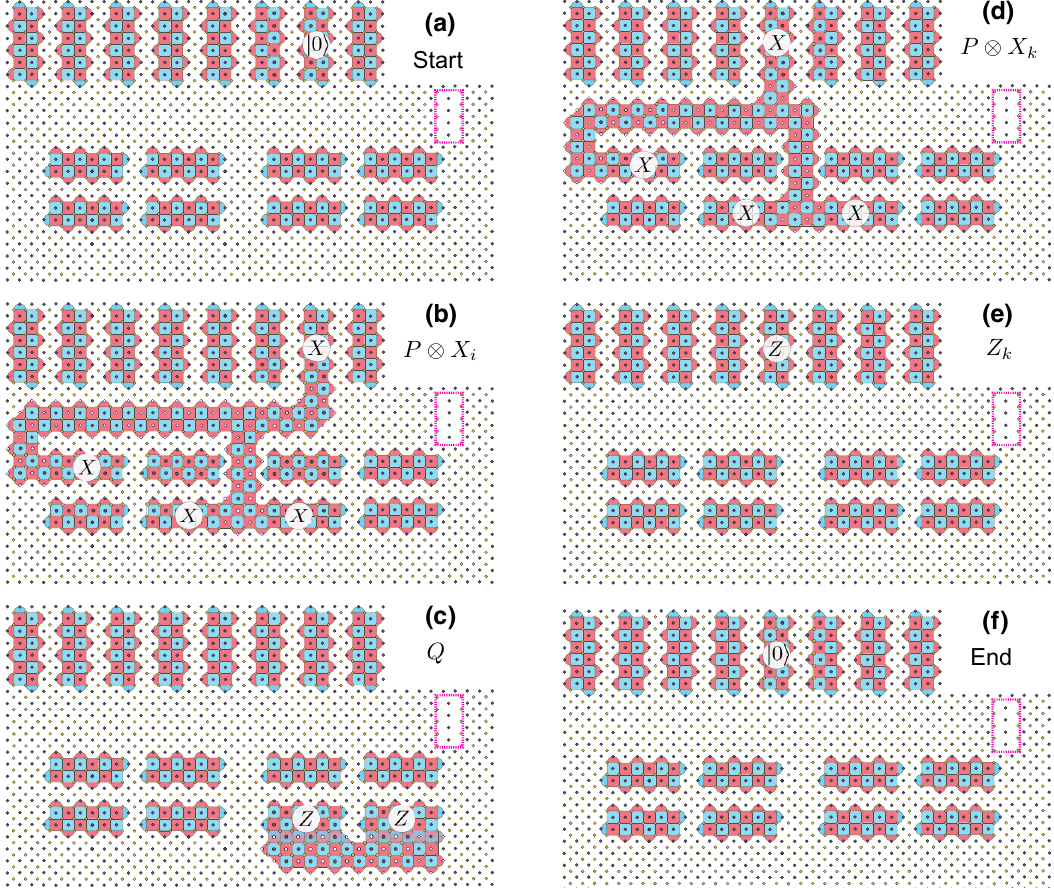
FIG. 17. Example lattice-surgery diagrams for using write to cache and read from cache to exchange qubits j and k between core and cache. (a) An illustration of the initial configuration with a | 0 (cid:3) ancilla (index label i ) in the cache. Qubit j is in the core and qubit k is in the cache and we wish to swap their locations. (b) We measure P ⊗ X i , where P = CX j C † , in which C is the Clifford frame. For simplicity, we assume that P is composed of only X operators. (c) We measure Q = CZ j C † and this time assume that it is